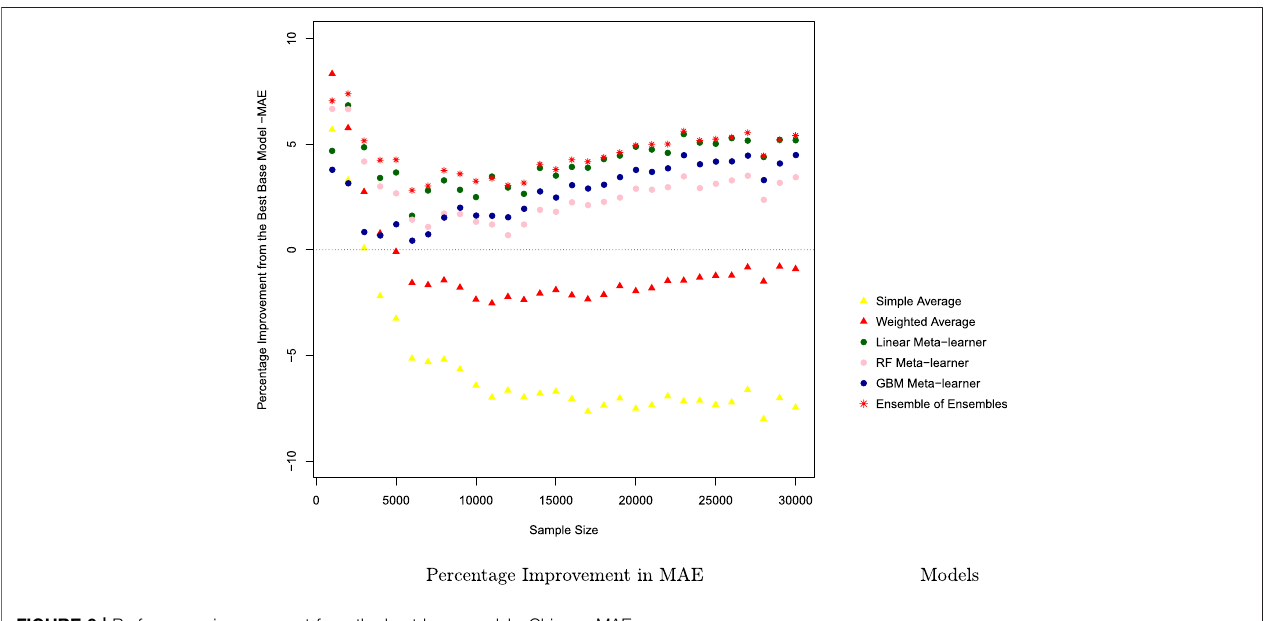
FIGURE 9 | Performance improvement from the best base model — Chicago MAE